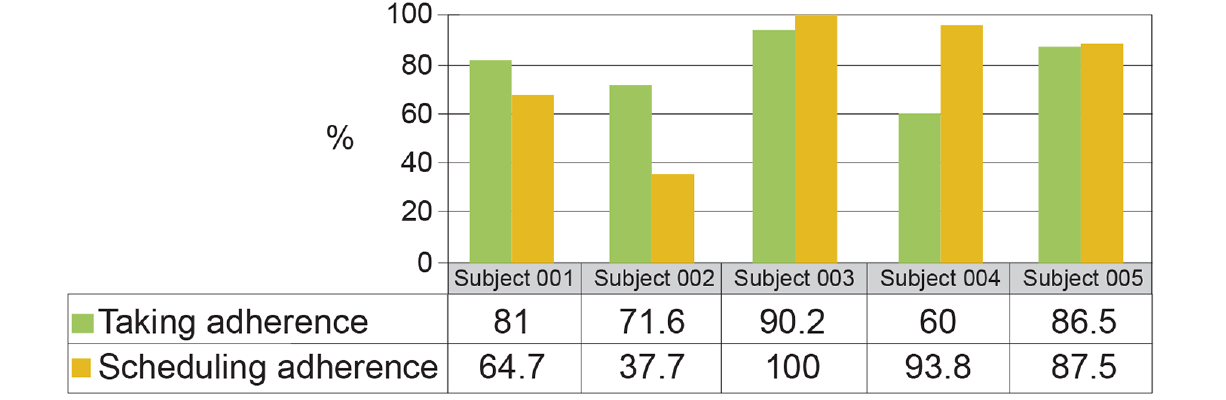
Figure 2. Standard representation of medication taking and scheduling adherence across study period by subject.